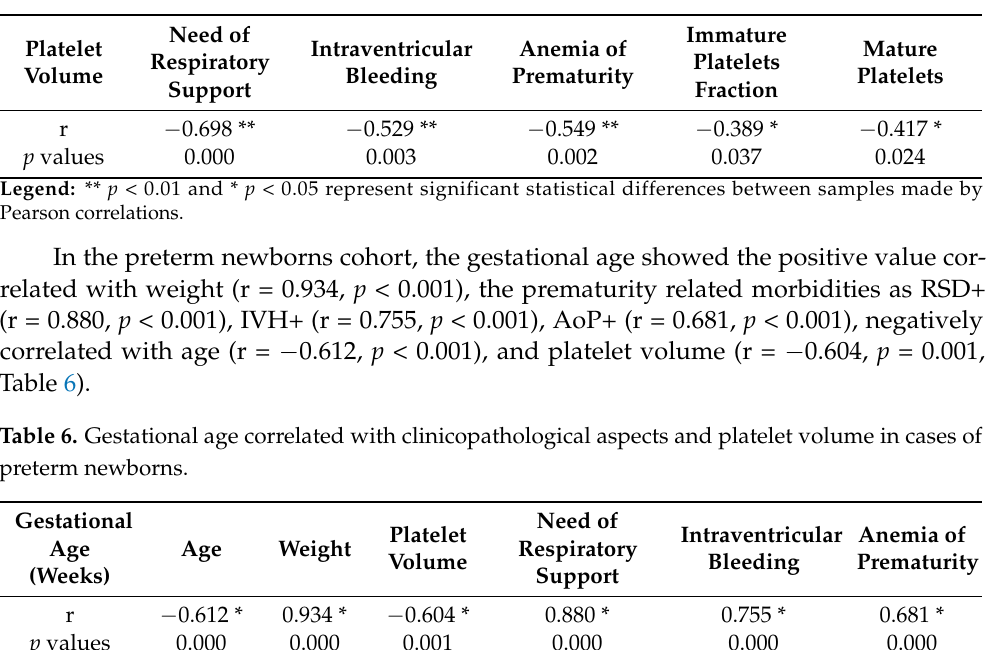
Table 5. Platelet volume correlated with the clinicopathological characteristics and flow cytometry platelet parameters in preterm newborns.